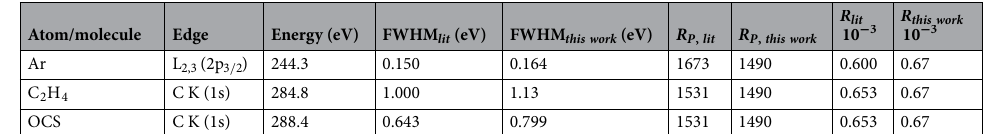
Table 1. Experimentally measured (this work) spectral resolution of the CCD-based spectrometer and (literature) values, extracted from literature. The resolving power ( R p ) is given by: R P = 1 resolution ( R ) is equal to R p